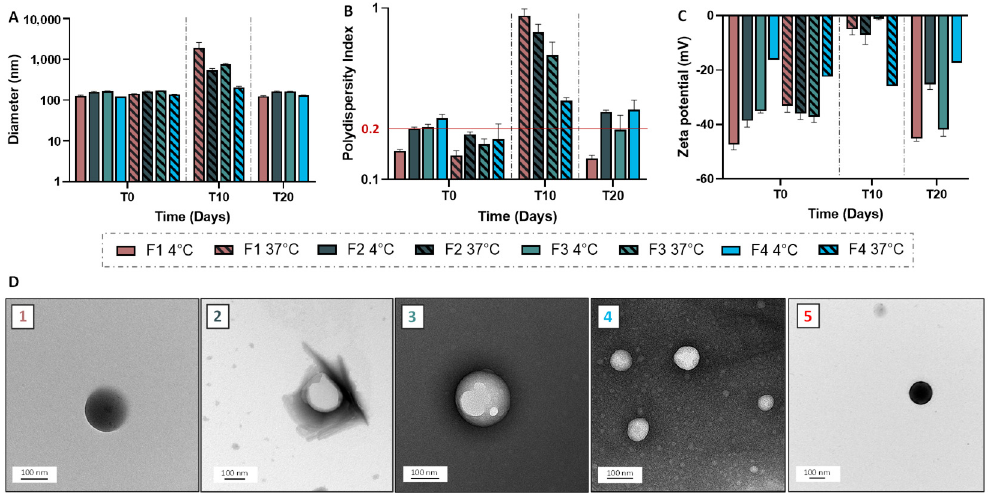
Figure 2. Physicochemical characterization of the rapid mixing formulations. Evolution of ( A ) the diameter, ( B ) polydispersity index (PdI), and ( C ) ζ -potential of F1 (red), F2 (dark blue), F3 (green), and F4 (cyan) overtime at 4 °C and 37 °C. ( D ) TEM images of ( 1 ) F1 , ( 2 ) F2 , ( 3 ) F3 , ( 4 ) F4 and ( 5 ) F5 prepared by rapid mixing.